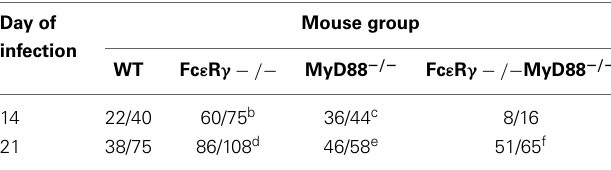
a Arthritis prevalence was reported as the number of joints with inflammation over the total number of joints examined in each group. The day 14 data are the prevalence combined from two separate experiments, and at day 21 the data for the prevalence are combined from four experiments. Statistically significant differences were found between the following groups. b FceR γ − / − vs. WT P = 0.009 and vs. FceR γ − / − MyD88 − / − P =